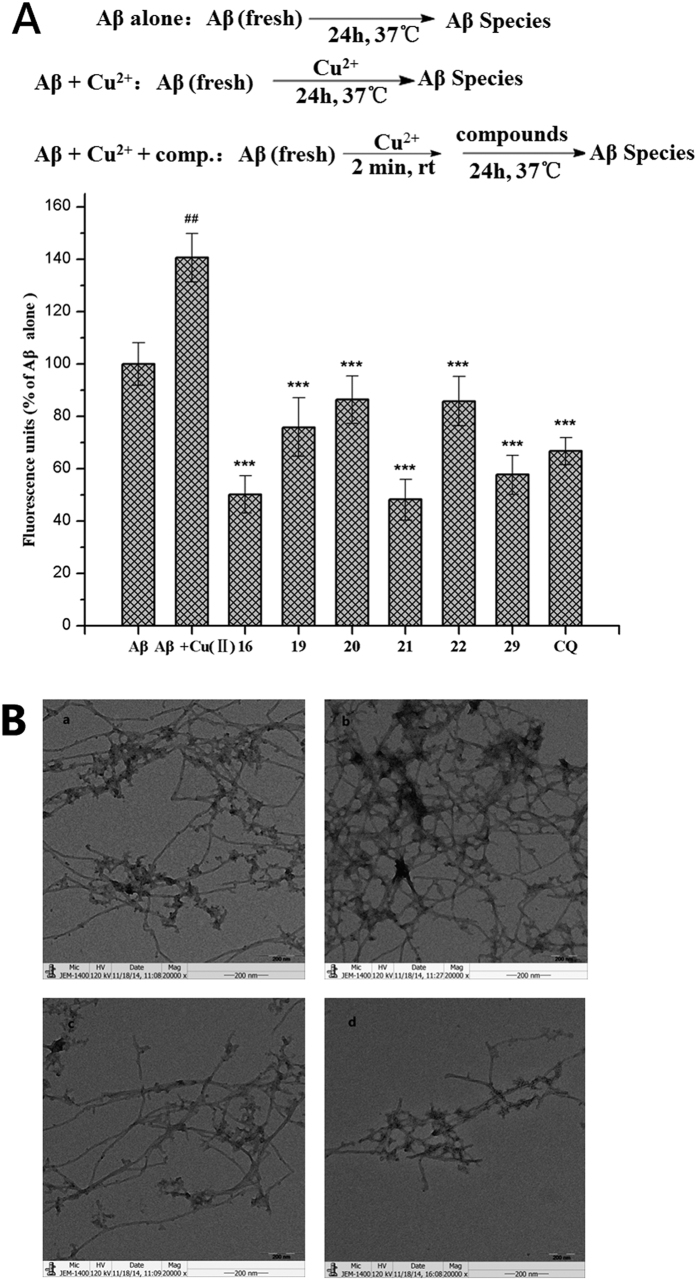
Inhibition of Cu2+- induced Aβ1-42 aggregation.(A) The results of the ThT binding assay. Statistical significance was analyzed by the Student’s t-test and ANOVA: (##)F1,4 = 32.94, p < 0.01, versus Aβ1-42 alone; (***) F1,4 = 138.03 (16), F1,4 = 67.95 (19), F1,4 = 60.50 (20), F1,4 = 158.06 (21), F1,4 = 62.59 (22), F1,4 = 116.09 (29) F1,4 = 106.69 (CQ), p < 0.001, versus Aβ1-42 + Cu2+ ([Aβ1-42] = 25 μM, [CQ] = 50 μM, [16] = [19] = [20] = [21] = [22] = [29] = 50 μM, [Cu2+] = 25 μM). (B) TEM images [[Aβ1-42] = 25 μM, [CQ] = 50 μM, [16] = 50 μM, [Cu2+] = 25 μM, 37 °C, 24 h]. (a) Aβ alone; (b) Aβ + Cu2+; (c) Aβ + Cu2+ + CQ; (d) Aβ + Cu2+ +  16.